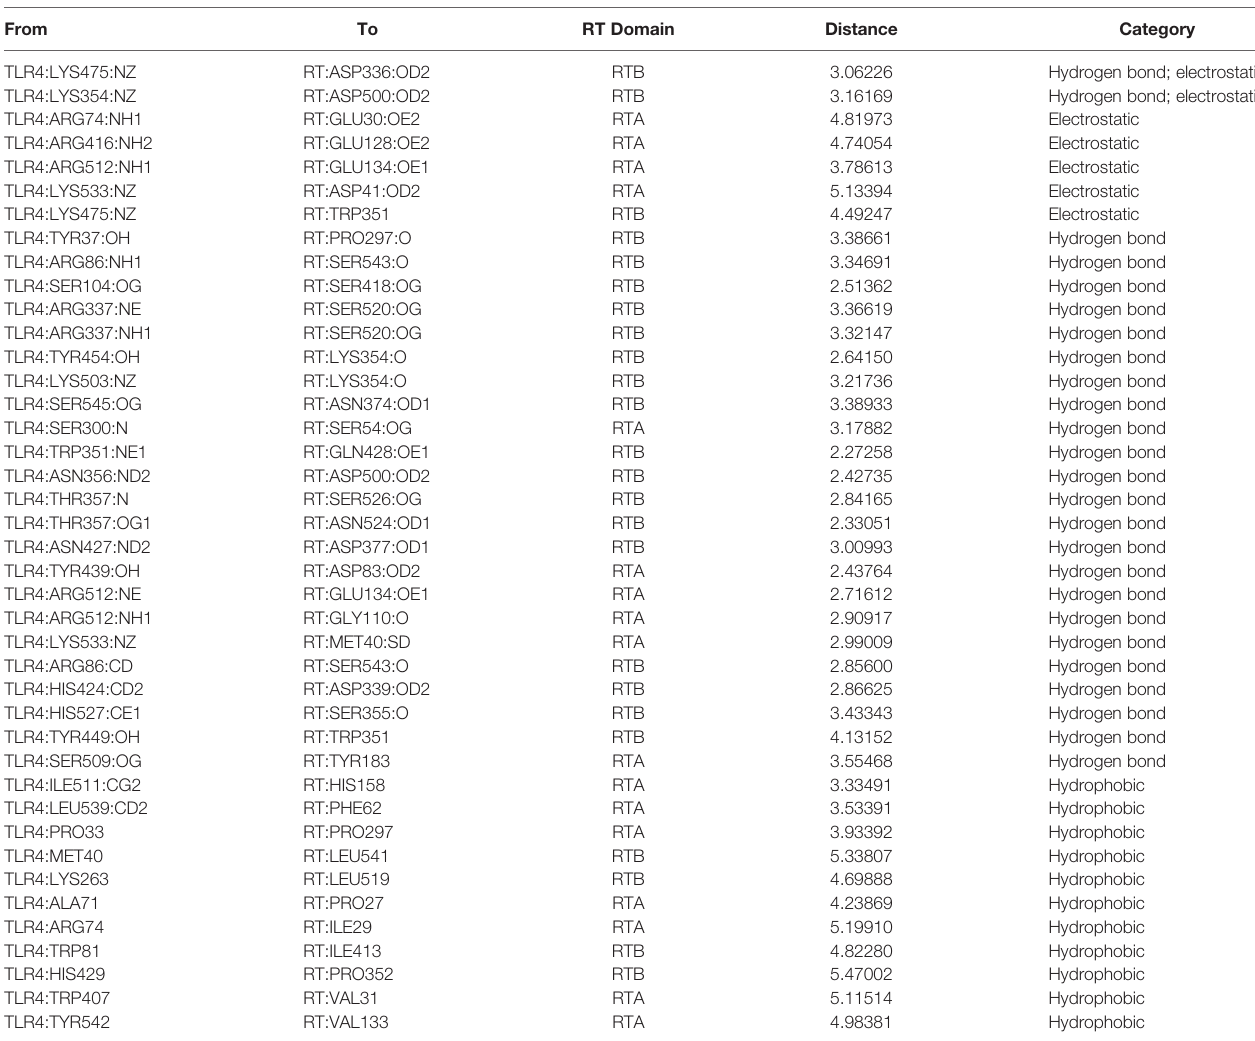
TABLE 1 | The binding interface and area of RT and TLR4. From To RT Domain Distance